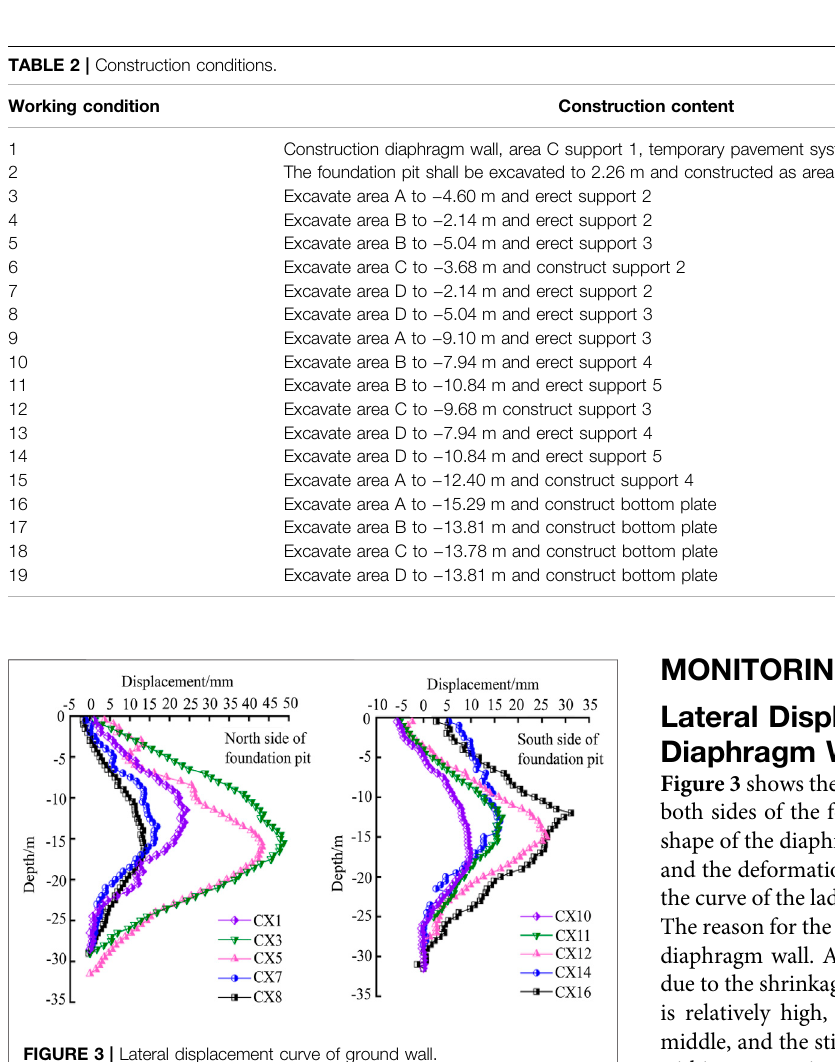
FIGURE 3 | Lateral displacement curve of ground